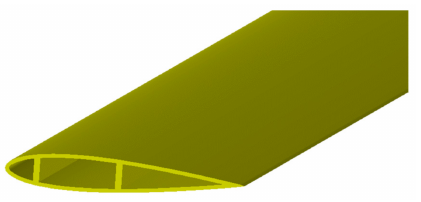
Figure 5. Three-dimensional geometry model of the optimized